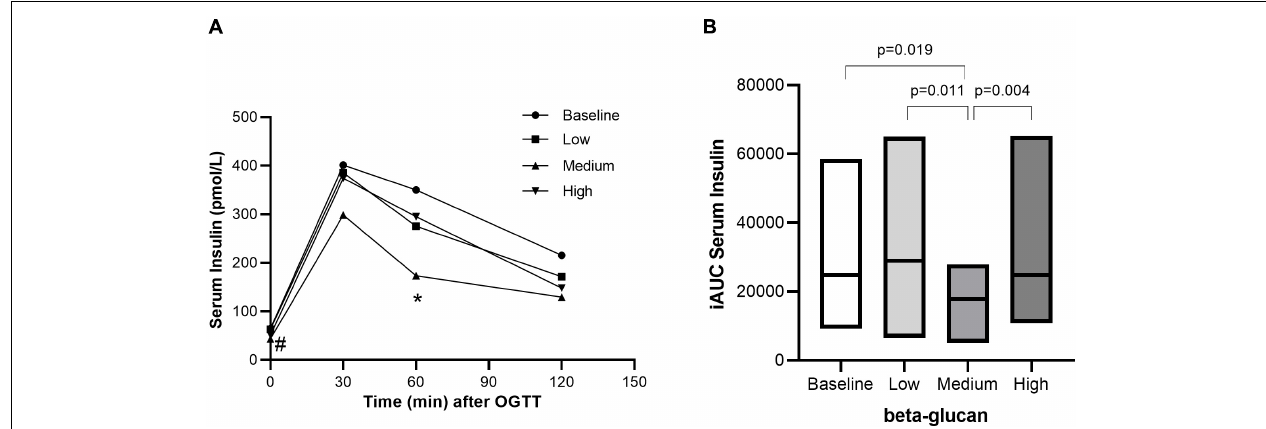
FIGURE 4 | Postprandial serum insulin response after intake of granola with cereal beta-glucan. The postprandial insulin response from 0–120 min (A) and the incremental area under the curve (B) after an OGTT at baseline and after consuming low, medium and high amount of beta-glucan for three days. Data is given as median (25 th –75 th ). Significant differences are calculated with Friedman’s Anova followed by Wilcoxon signed rank test. #Fasting insulin after medium and high beta-glucan significant different from baseline. *Insulin response at 60 min after medium beta-glucan significant different from baseline, low and high beta-glucan. TABLE 5 | Insulin resistance (HOMA-IR) and insulin sensitivity (Matsuda index) after intake of granola with cereal beta-glucan in different amounts. Baseline Low beta-glucan Medium beta-glucan High beta-glucan p-value # HOMA-IR Matsuda